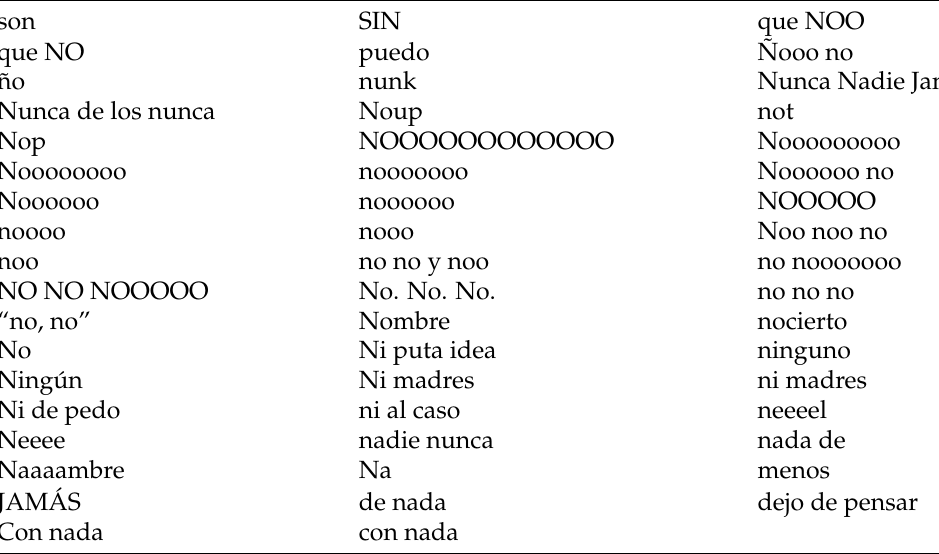
Table A2. Simple negation cues with one occurrence.